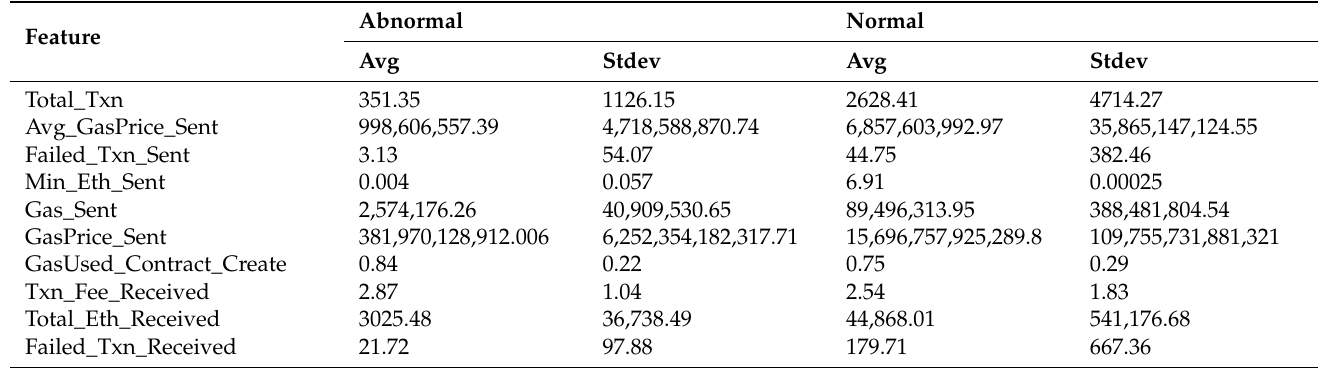
Table 5. Statistics of top 10 transaction-based feature